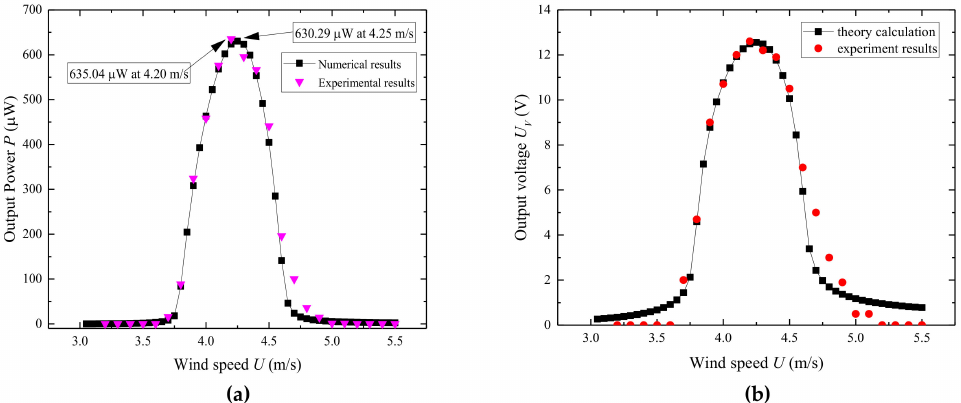
Figure 4. Numerical results and experimental results: ( a ) output power P versus wind speed U; ( b ) output voltage U V versus wind speed